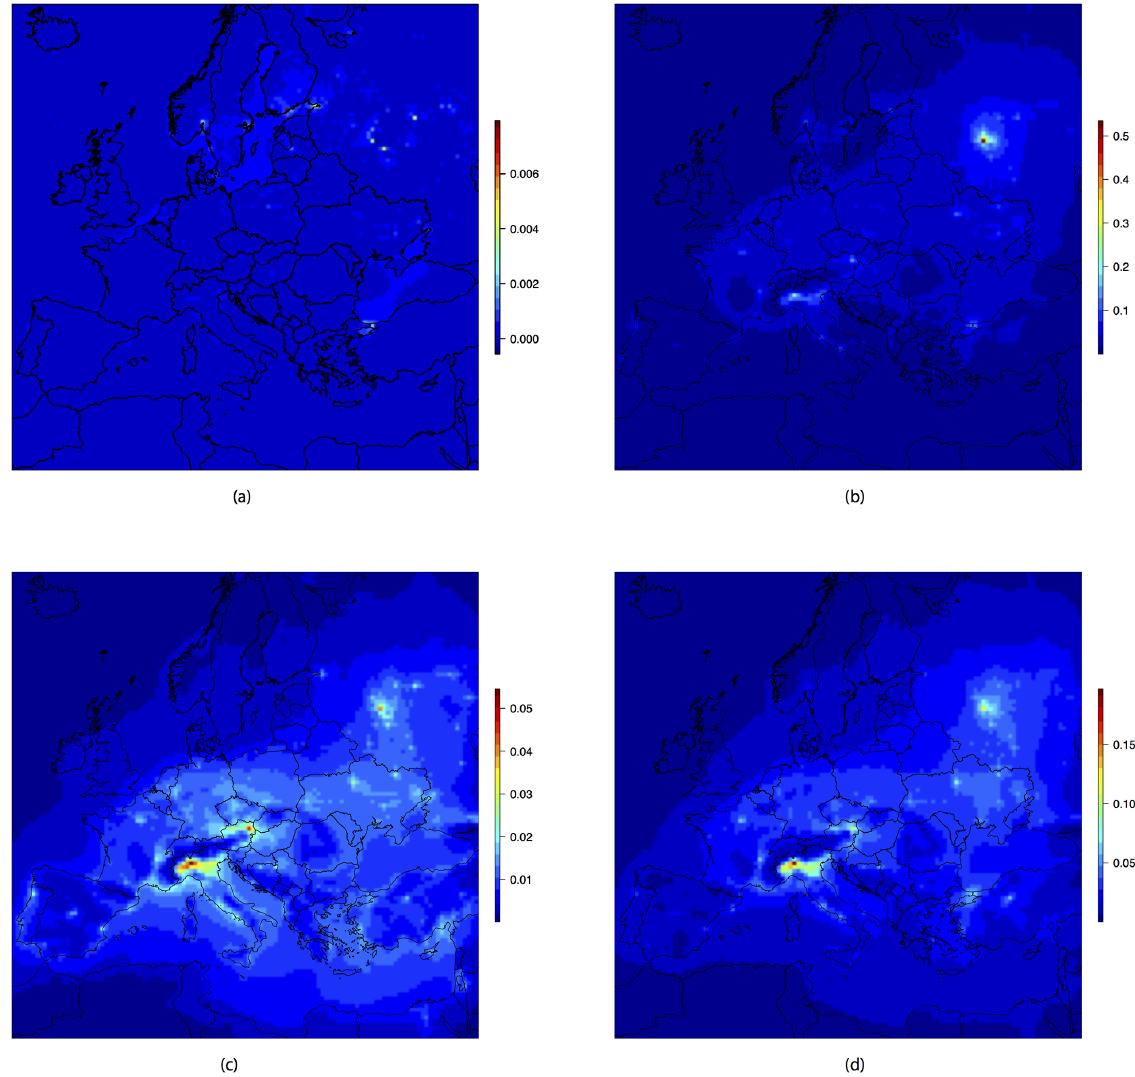
Figure 3. Differences in annual average surface-level BaP concentrations (ngm − 3 ) during 2006 plotted for (a) water dissolution effect: scenario 1 to scenario 2, (b) K oa effect: scenario 3 to scenario 2, (c) dual model effect: scenario 4 to scenario 3, and (d) O 3 degradation effect: scenario 4 to scenario